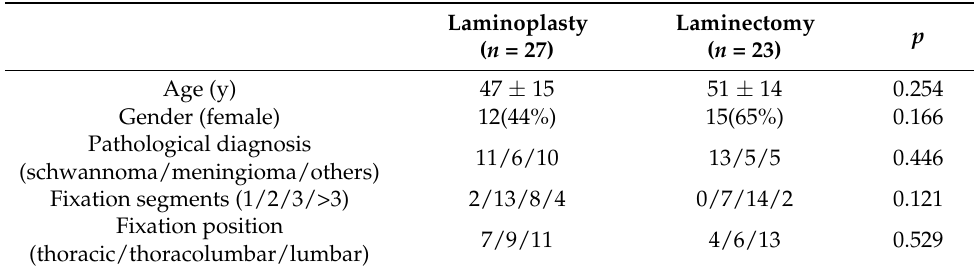
Table 1. Baseline characteristics of the enrolled patients.